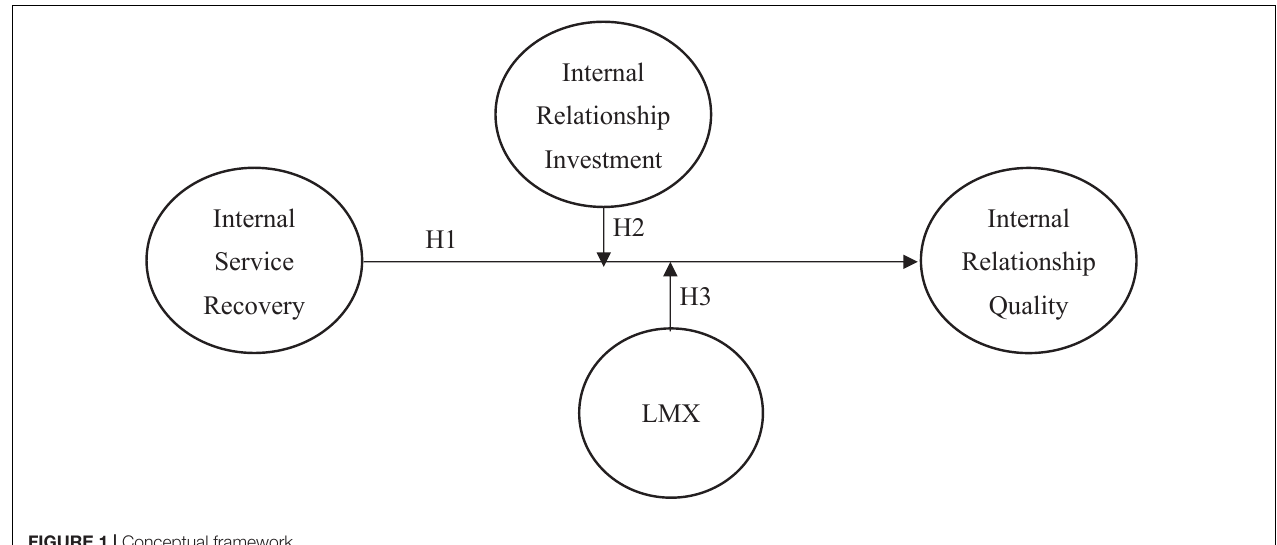
FIGURE 1 | Conceptual framework.